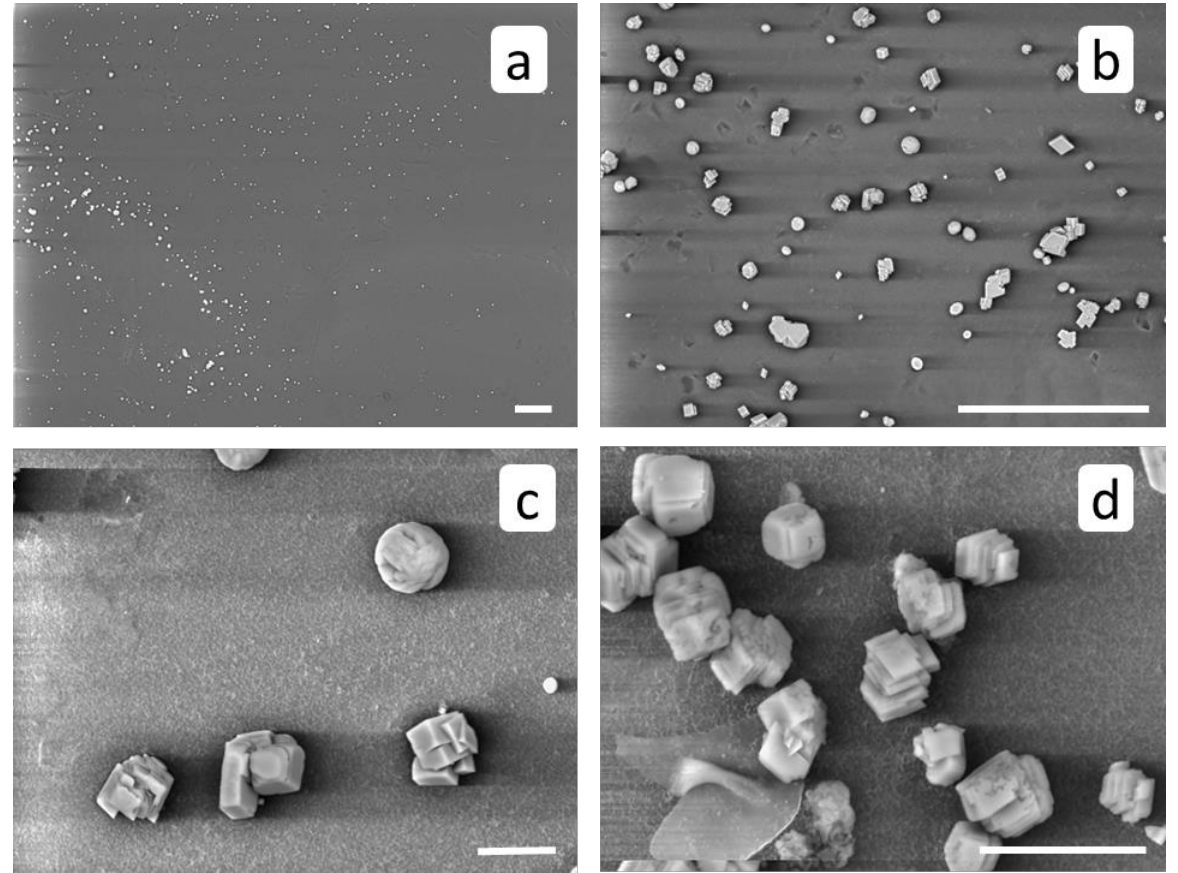
Figure 7. SEM images of membrane surface after RO treatment in the presence of HEDP-F. Scale marker corresponds to 100 μm ( a , b ) or to 10 μm ( c , d ).